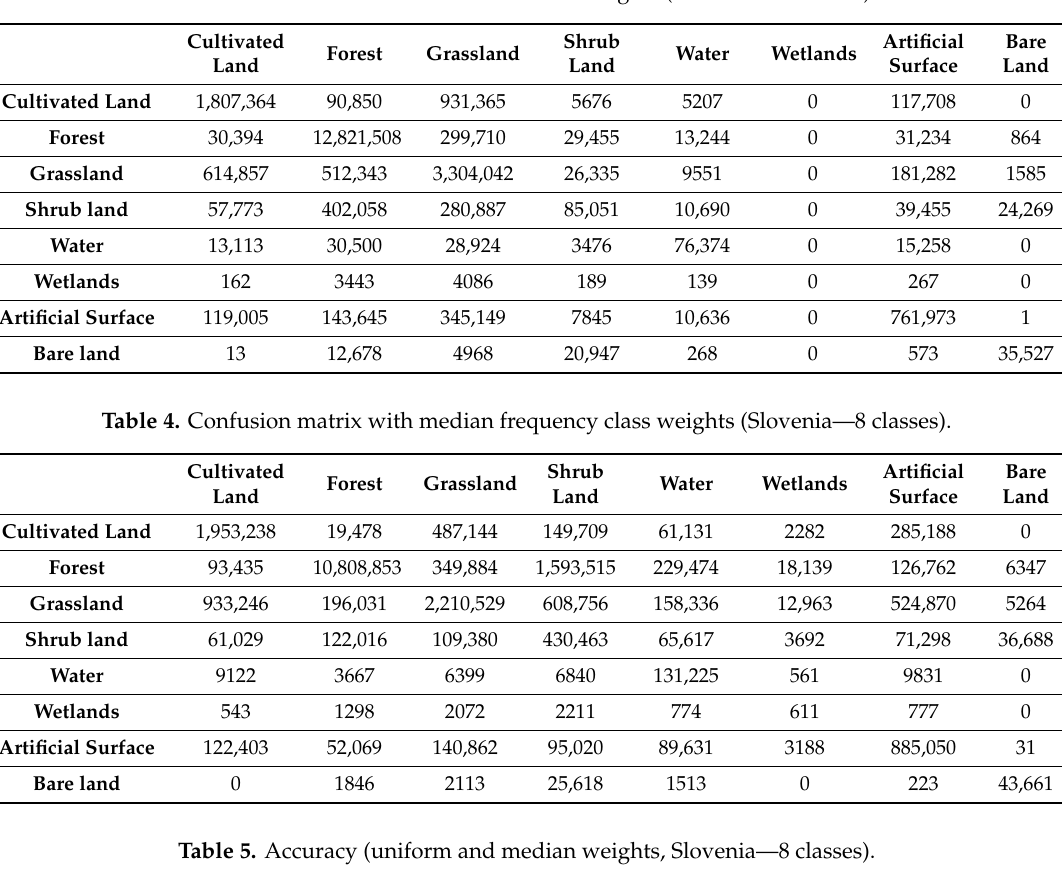
Table 3. Confusion matrix with uniform weights (Slovenia—8 classes).